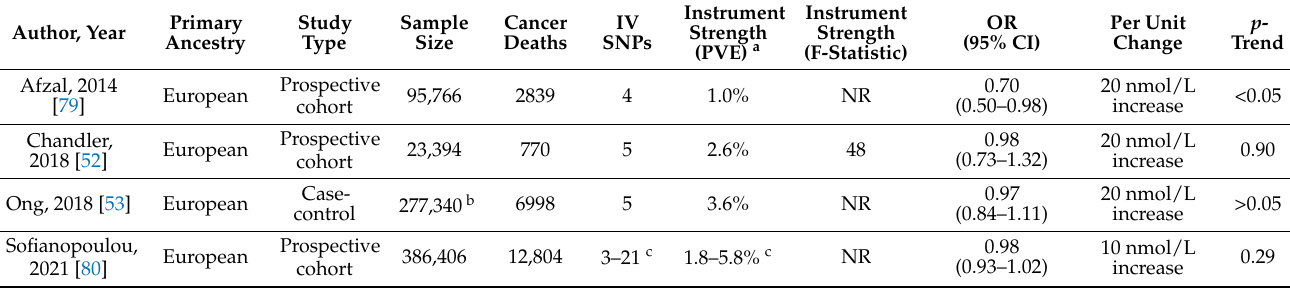
Table 2. Summary of all published Mendelian randomization (MR) estimates for the association between serum 25-hydroxyvitamin D and cancer-specific mortality. Additional study details are displayed in Supplementary Table